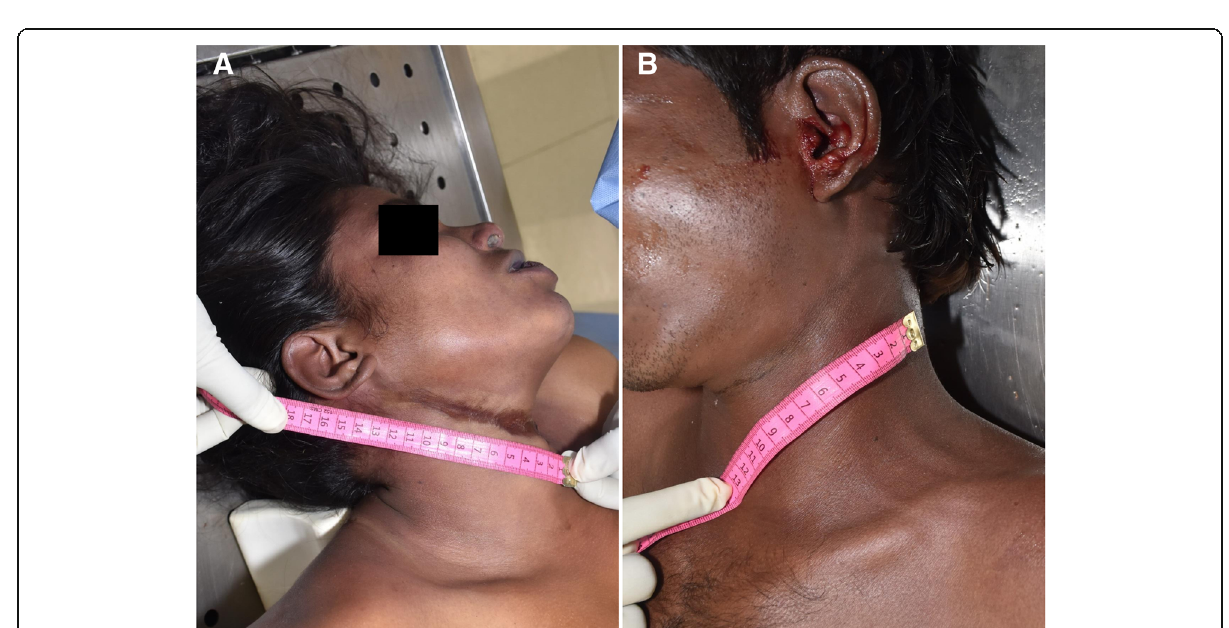
Fig. 2 a , b Ligature mark in the female and male victims